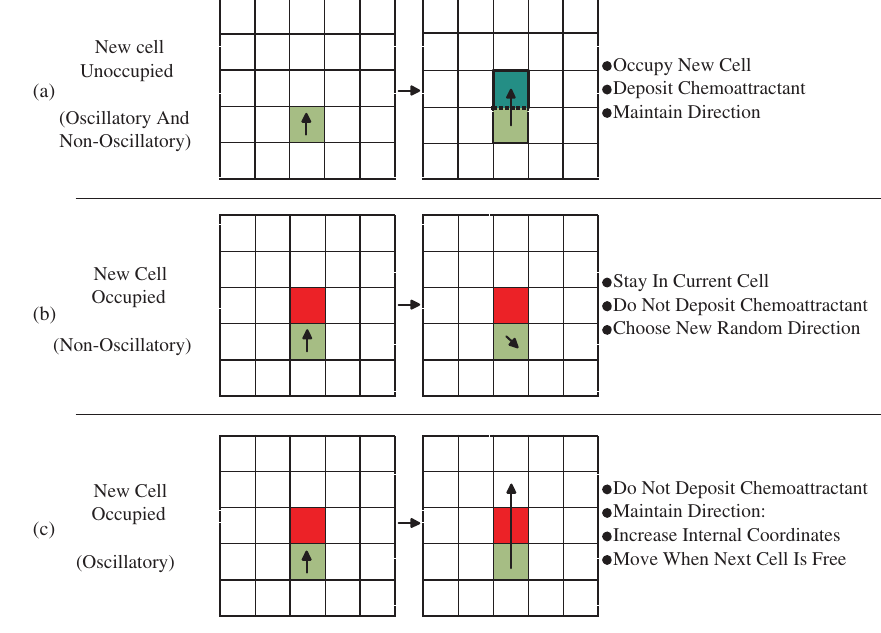
Fig. 9. Particle motor behaviour in non-oscillatory and oscillatory